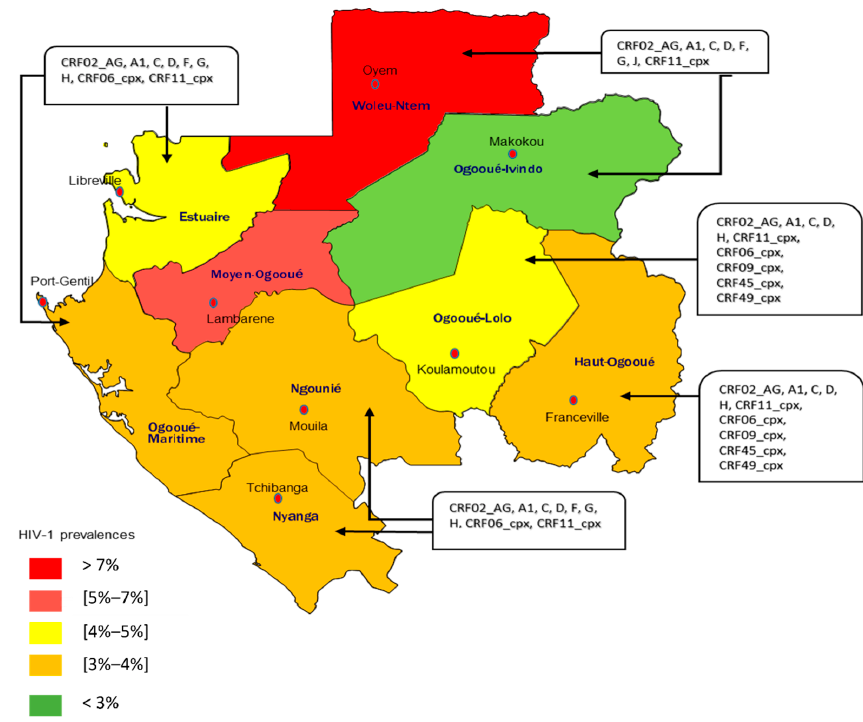
Figure 1. Distribution of HIV-1 subtypes in Gabon and the prevalence by province.